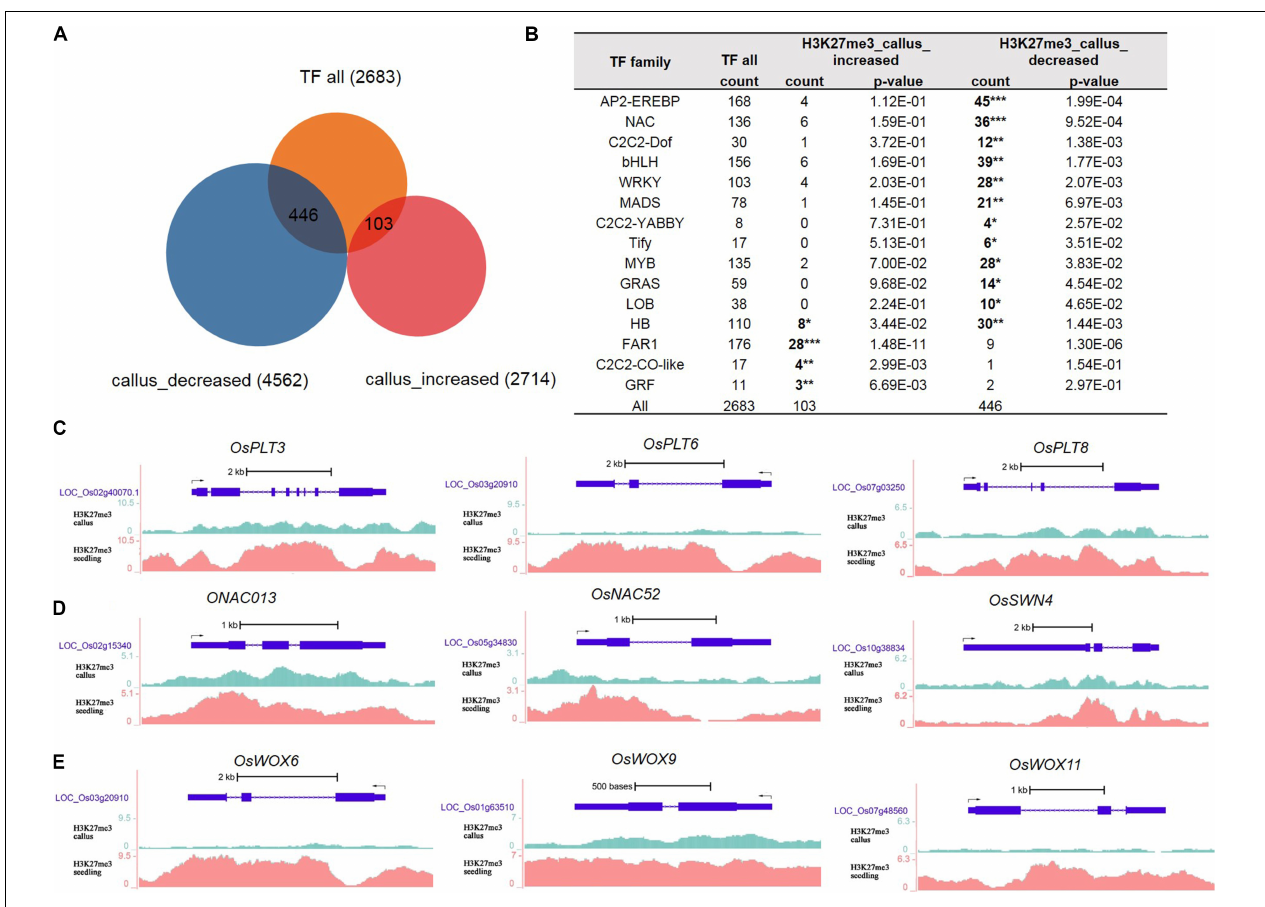
FIGURE 2 | Transcription factor analysis of genes deposited by H3K27me3 in callus and seeding, respectively. (A) Venn diagrams for 2,683 TFs and H3K27me3-targeted genes between callus and seedling. (B) Transcription factor (TF) families enriched in preferentially deposited H3K27me3 in callus and seedling, respectively. (C) Genes in the AP2/EREBP family are associated with H3K27me3 according to data in the UCSC genome browser. (D) Genes in the NAC family are associated with H3K27me3 according to the UCSC genome browser. (E) Genes in the HB family are associated with H3K27me3 according to the UCSC genome